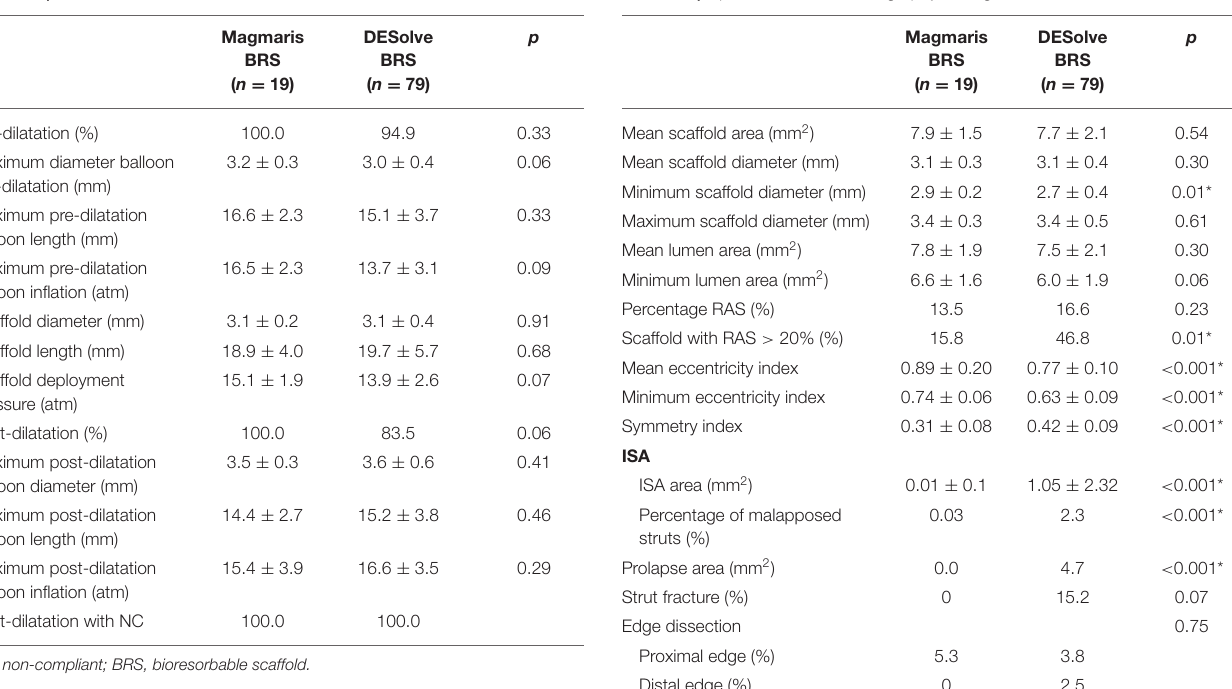
TABLE 3 | Procedural characteristics. TABLE 4 | Optical coherence tomography